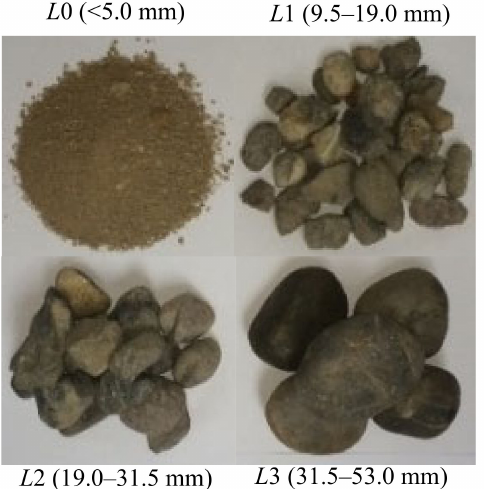
Figure 3. Soil–rock mixture (SRM) test